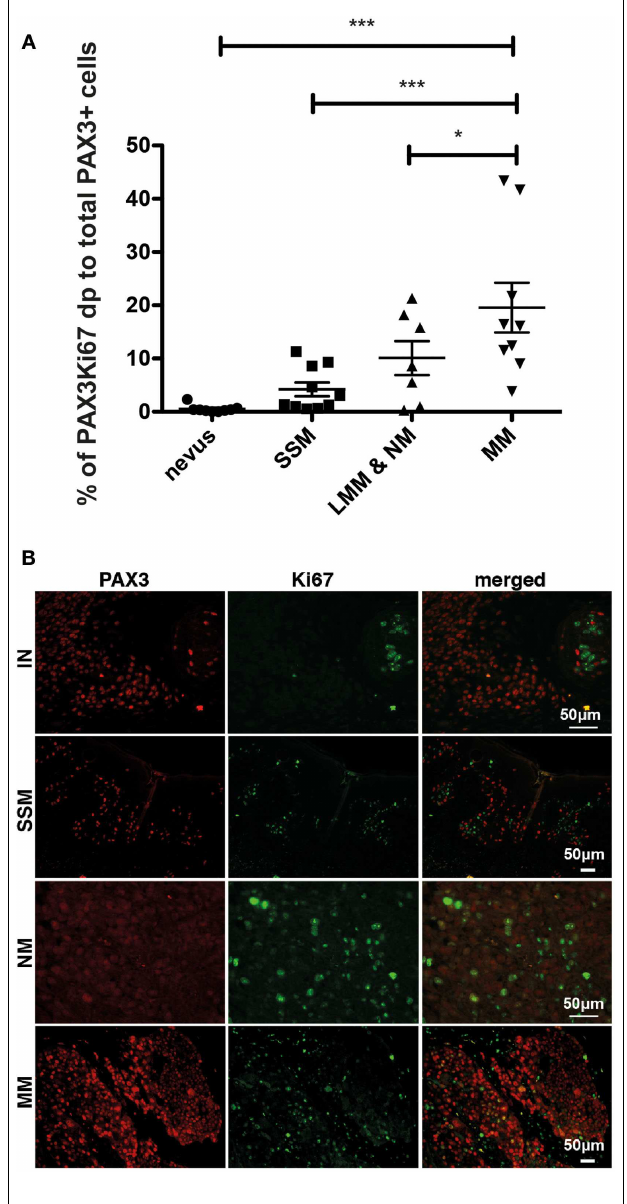
FIGURE 3 | Dual immunofluorescent staining of Ki67 and PAX3 in benign and malignant melanocytic lesions . (A) Graph showing the percentage of PAX3 and Ki67 double positive (dp) cells as a percentage of the total number of PAX3-positive cells for superficial spreading melanoma (SSM), lentigo maligna melanoma and nodular melanoma (LMM & NM), and metastatic melanoma (MM), *** p < 0.001. (B) Photomicrographs showing the results of immunofluorescent staining for PAX3, Ki67, and merged images for an intradermal nevus (IN), superficial spreading melanoma (SSM), nodular melanoma (NM), and metastatic melanoma (MM).The scale bar, which varies in length on the images, represents 50 µ m.